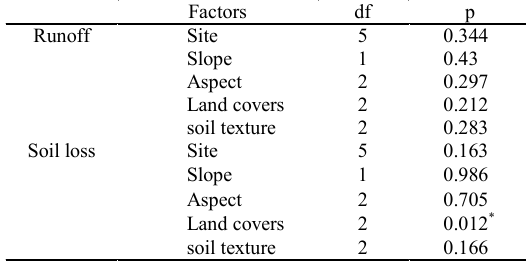
Table 5: The classes of each factor Table 6: The results of Kruskal-Wallis test slope, aspect, land covers and soil texture with runoff and soil loss